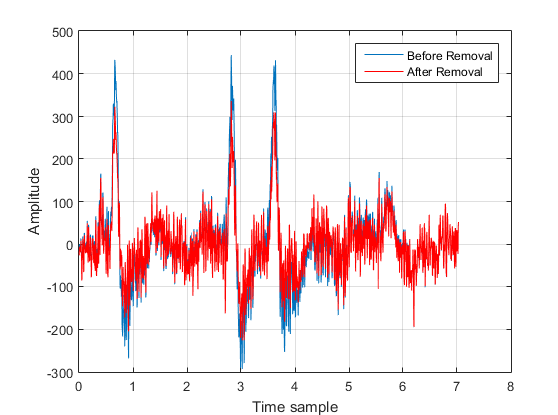
Fig. 4. Artifactual Data and Reconstructed Data